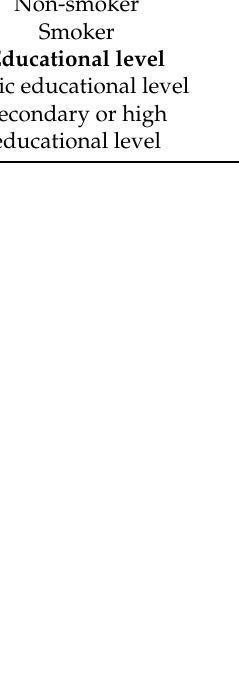
Table 2. Biochemical variables by